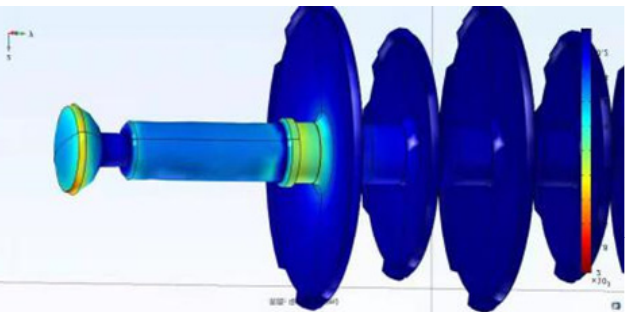
Coatings 2022 , 12 , 898 Figure 7. Simulation of the electric field at the high-voltage end of sample #1 after moisture absorption.